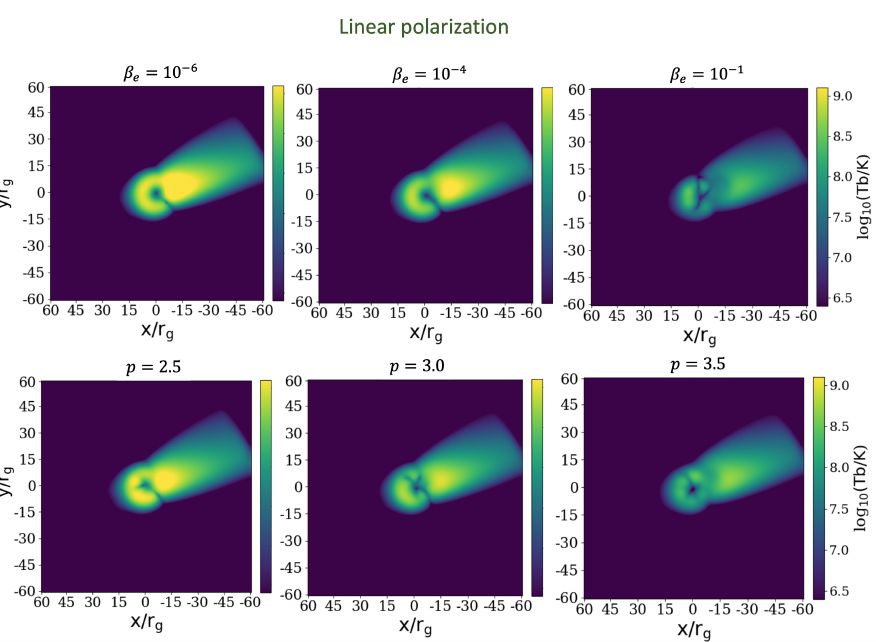
Figure 3. The (log)-linear polarization map for the constant β model with f pos = 0.1. ( Top panel ) shows the case with p = 3.5. From the left to right we change β e = 10 − 6 ,10 − 4 ,10 − 1 . ( Bottom panel ) presents the case with fixed β e = 10 − 2 , also from the left to right, we change p = (2.5, 3.0, 3.5). These images are corresponded to ν = 230